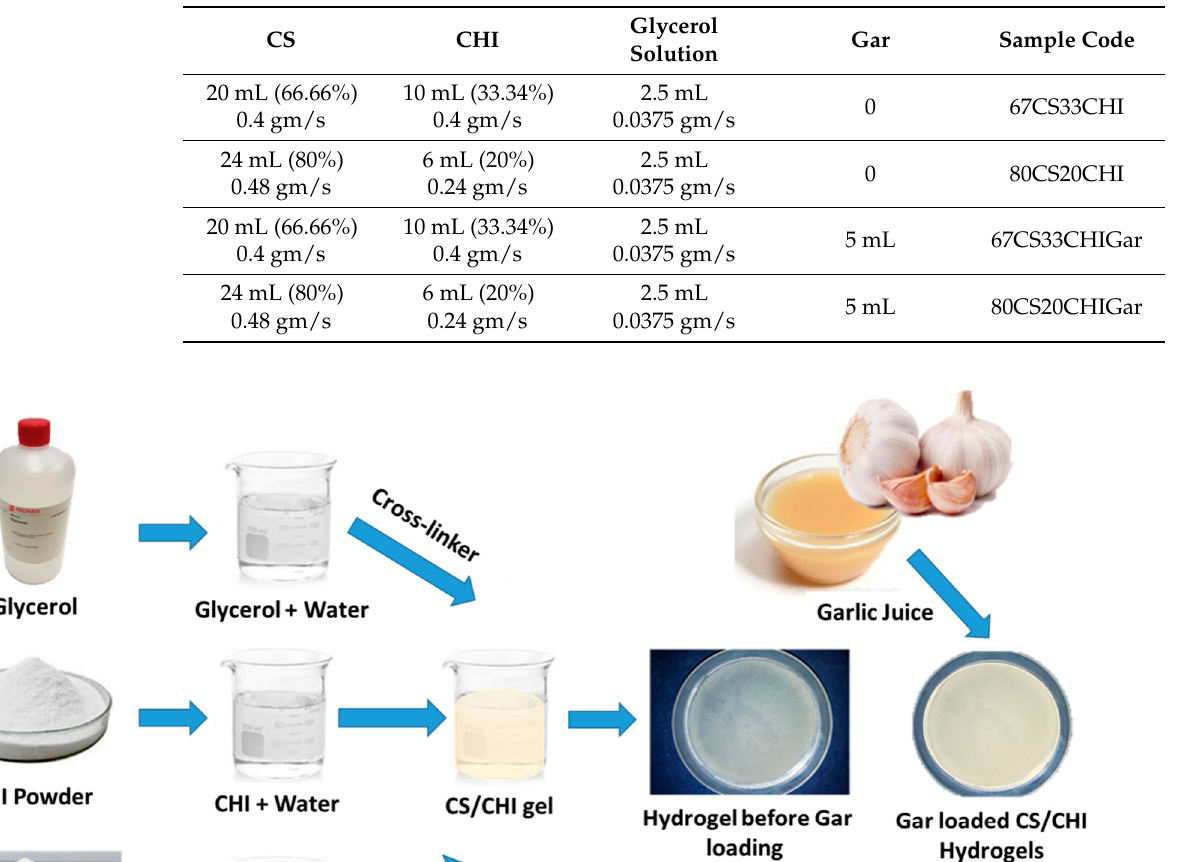
Table 3. Composition of CS, CHI, Gar and glycerol in hydrogels.